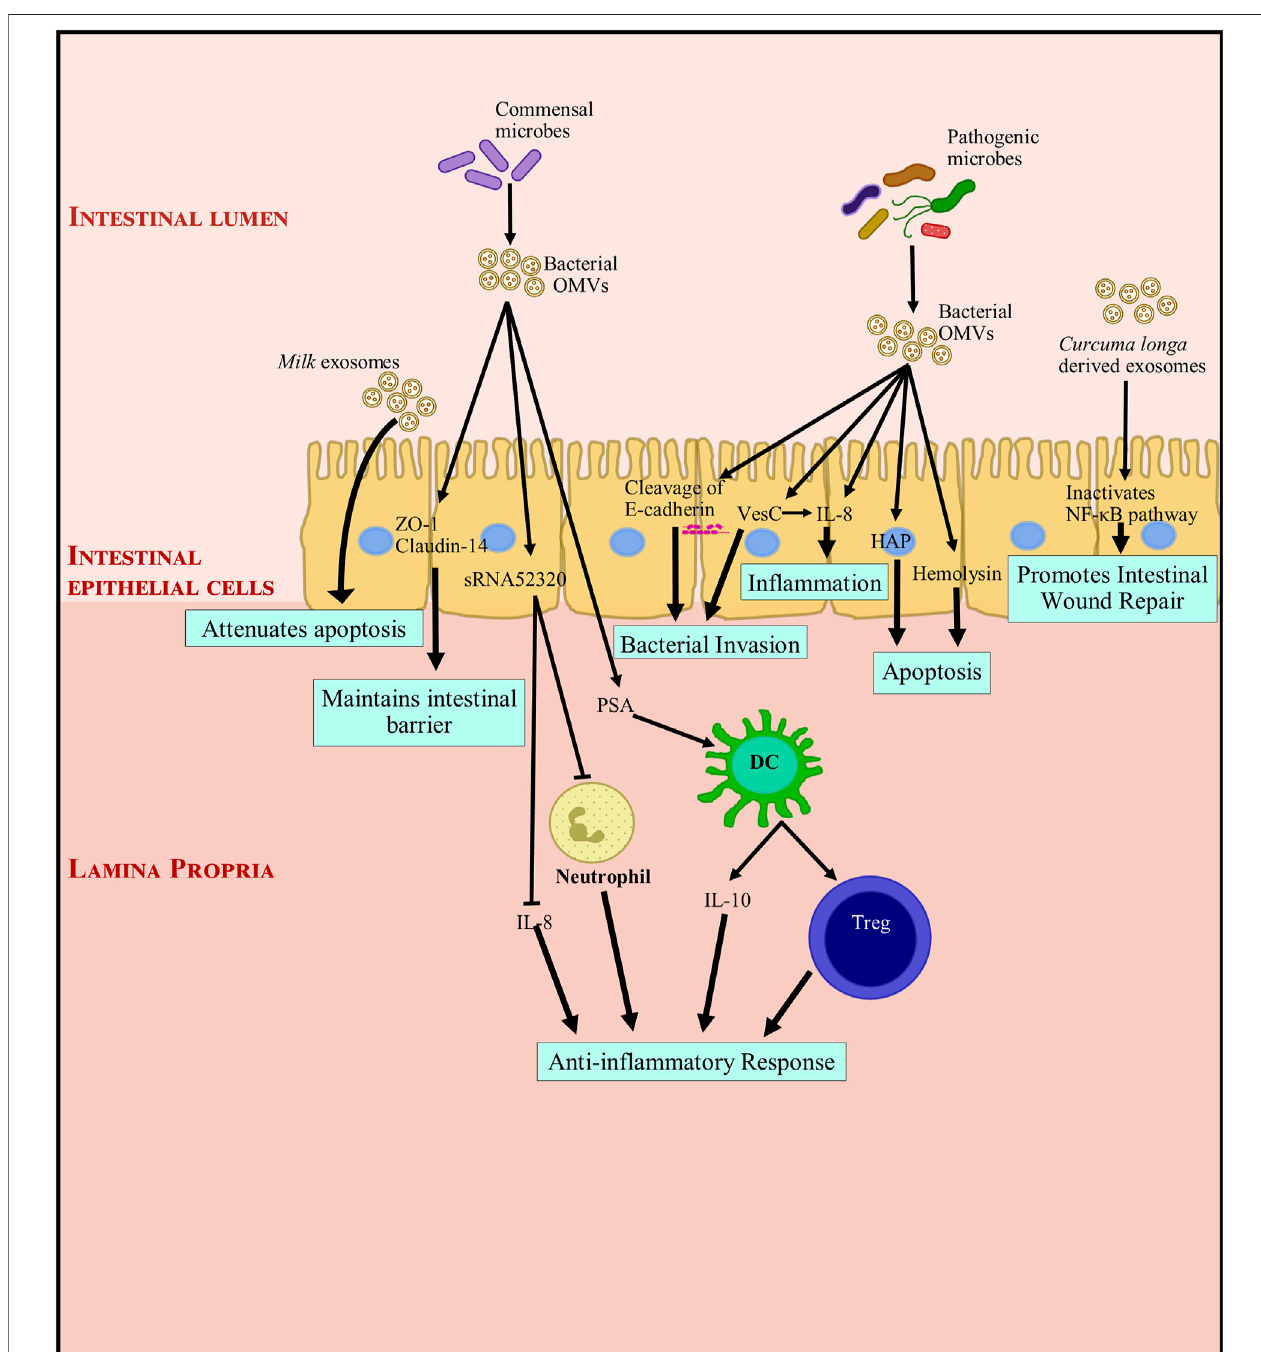
FIGURE3| Modulation ofintestinal in fl ammationbymicrobiomederivedoutermembranevesiclesand dietary exosomes. Exosomes and OMVs (outermembrane vesicles) through their functional components, directly or indirectly interact with gut intestinal epithelial cells (IECs). Dietary exosomes attenuate apoptosis and promote intestinal wound repair. OMVs from commensal bacteria induce the proliferation of IECs and development of the intestinal tract, and indirectly enhance barrier functions by inhibiting components of the in fl ammatory environment that negatively impact tight junction molecules and IECs. They also interact with immune cells and promote an anti-in fl ammatory immune response. On the other hand, pathogenic bacteria, though their OMVs can induce in fl ammation and apoptosis. They can also cause a breach in the epithelial barrier by cleaving E-cadherin. This facilitates bacterial invasion and transmigration into the intestinal tissue. DC, dendritic cell; HAP, hemagglutinin protease; IL, Interleukin; NF- κ B, nuclear factor kappa light chain enhancer of activated B cells; OMV, outer membrane vesicle, PSA: capsular polysaccharide; sRNA52320, shortRNA 52320; Treg, regulatory T cell; VesC, calcium-dependent trypsin-like serine protease; ZO-1, Zonula occludens 1.